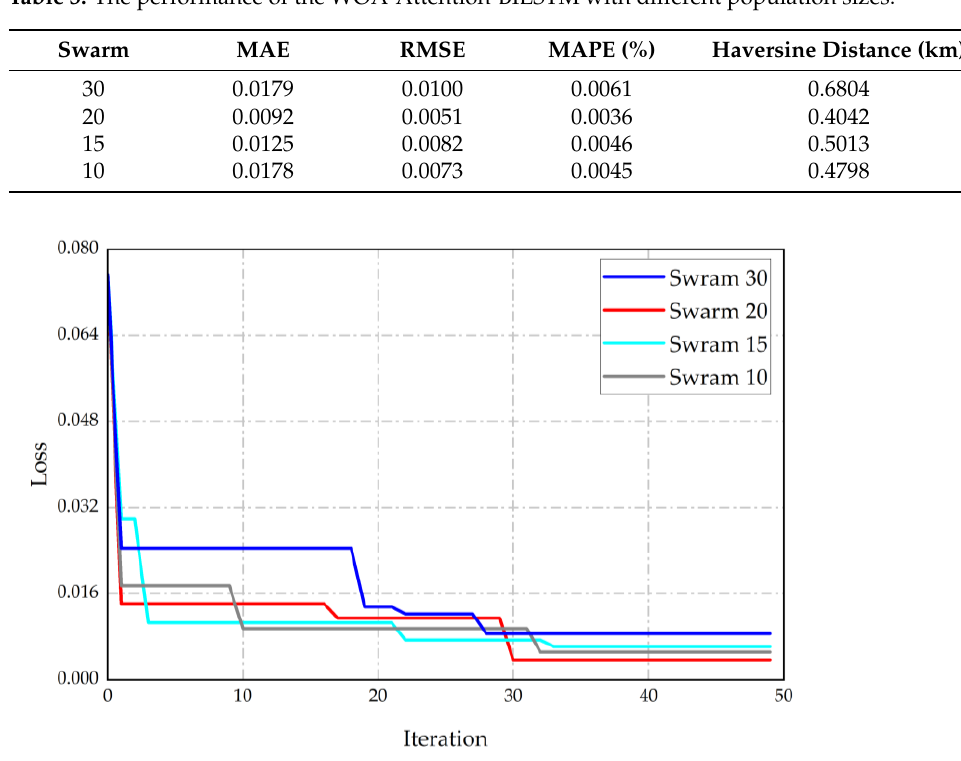
Figure 9. Optimization of WOA-Attention-BILSTM with different population sizes.